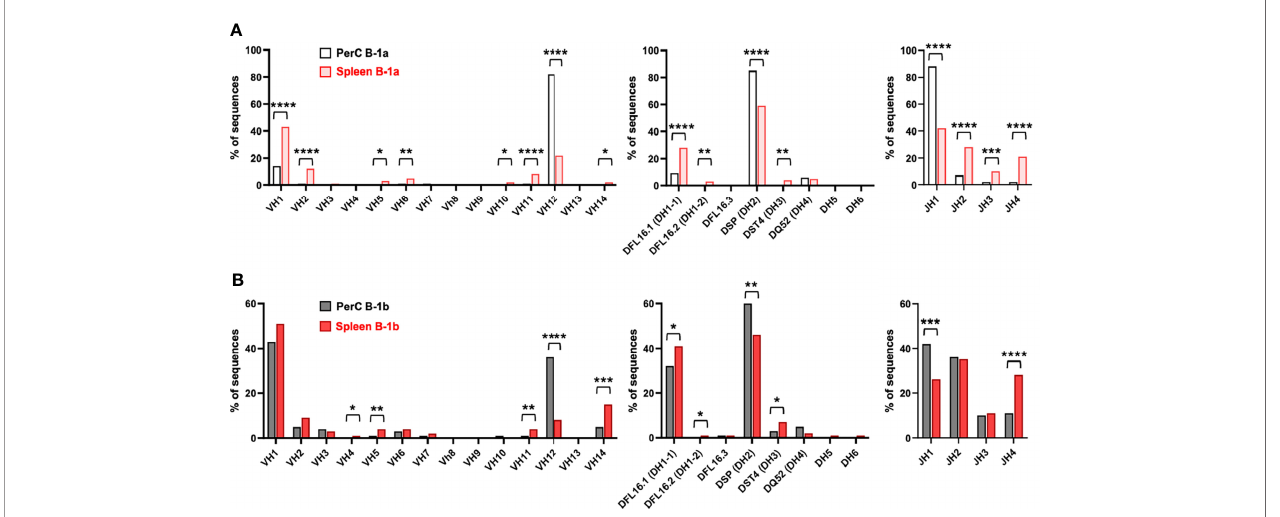
FIGURE 6 | B-1a and B-1b cell IgM CDR-H3 sequencing in the 100-week-old mice. Frequency of total sequences utilizing the given V H , D, and J H gene segments in the variable region of the immunoglobulin heavy chain from single cell-sorted (A) B-1a cells and (B) B-1b cells in both PerC and spleen of 100-week-old chow-fed ApoE -/- mice. *P < 0.05, **P < 0.01, ***P < 0.001, ****P <